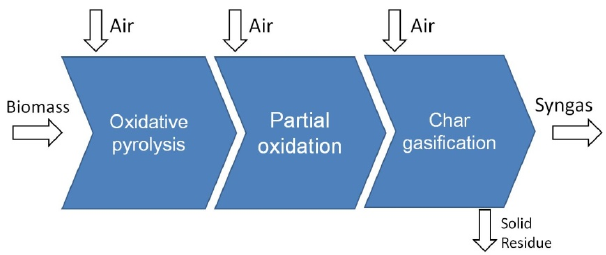
Figure 1. Conceptual schematic of the novel air staged biomass gasifier.